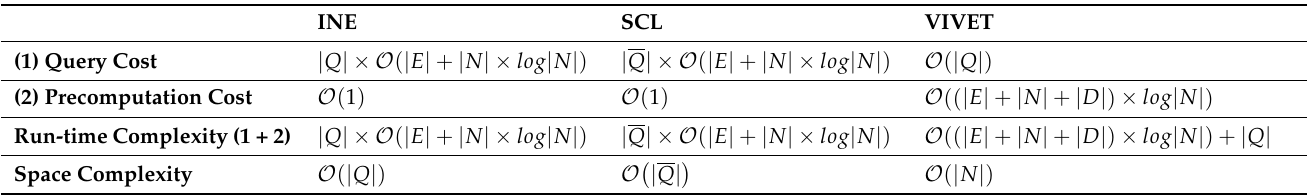
Table 6. Comparison of time and space complexities of INE, SCL, and VIVET INE